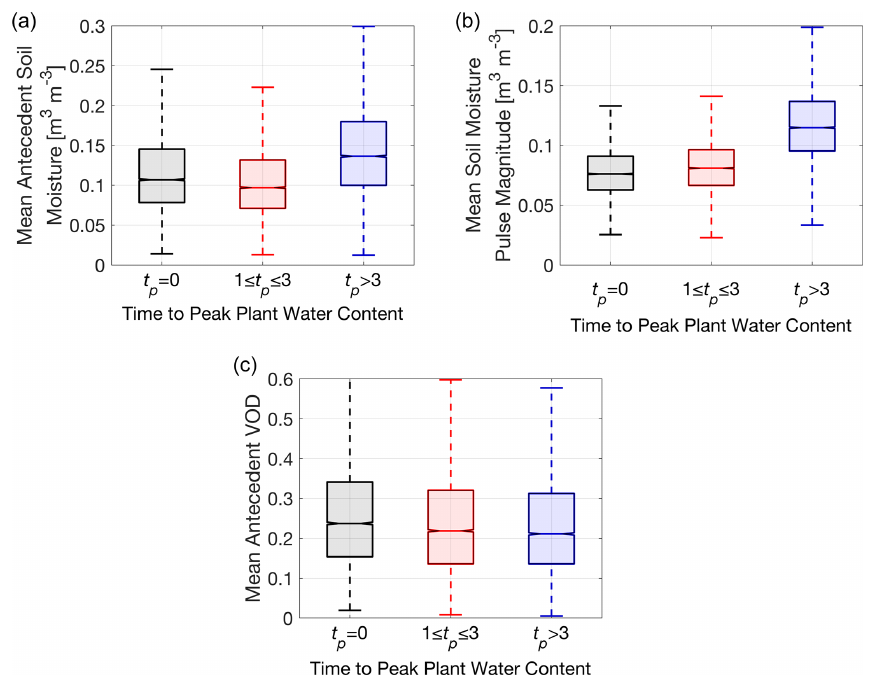
Figure 6. Global spatial distribution of pulse conditions binned as a function of rapid VOD response ( t p = 0), short VOD increases ( t p = 1– 3d), and long VOD increases ( t p > 3d) in regions with median t p ≥ 1d. Kruskal–Wallis (KW) tests indicate all group medians are sig- nificantly different within each panel, and pairwise Mann–Whitney U tests confirm that all possible combinations of differences in group medians across (a) , (b) , and (c) are significantly different ( p < 0 . 05). (a) Antecedent surface soil moisture (KW test p (cid:28) 0 . 01; χ 2 = 2200, υ = 2). A total of 77% of pixels have significantly positive linear relationships with t p ( p < 0 . 05). (b) Surface soil moisture pulse magni- tude (KW test p (cid:28) 0 . 01; χ 2 = 7819, υ = 2). A total of 85% of pixels have significantly positive linear relationships with t p ( p < 0 . 05). (c) Antecedent VOD (KW test p (cid:28) 0 . 01; χ 2 = 163, υ = 2). A total of 81% of pixels have significantly negative linear relationships with t p ( p < 0 .